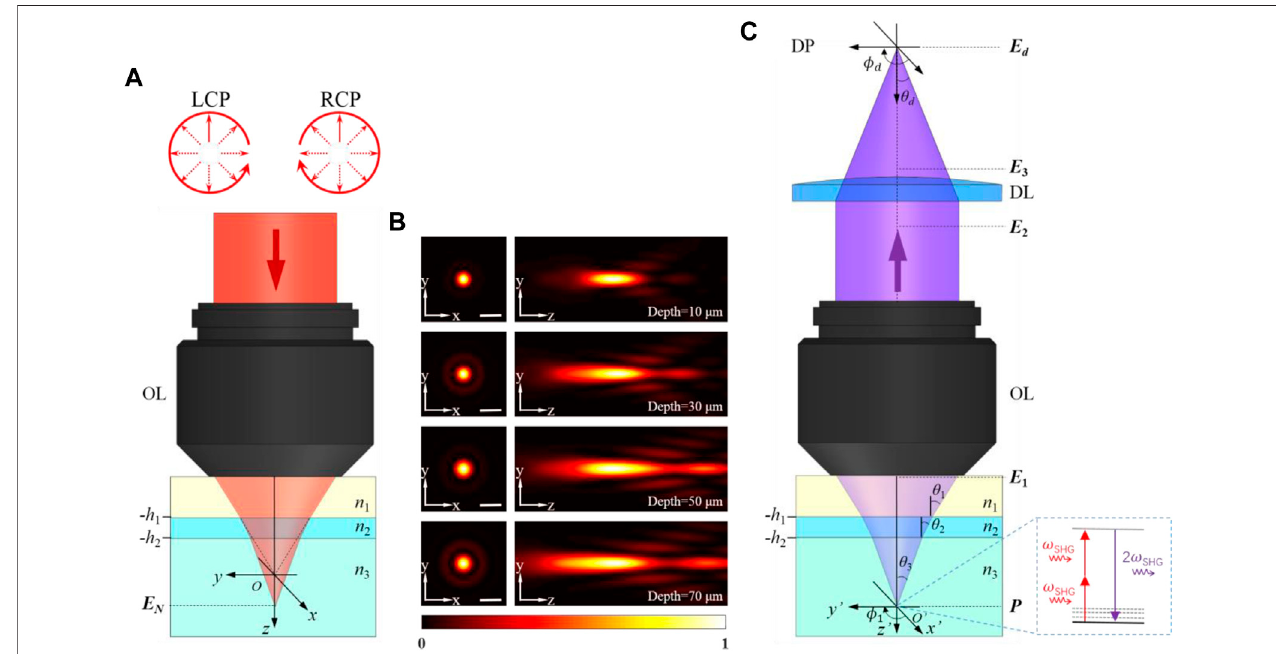
FIGURE1|(A) Schematicoffocusingthroughathree-layerstrati fi edmedium forleft-handedandright-handedcircularpolarizedbeams.Theorigin O ofthe( x , y , z ) reference frame locates at the nominal focal point position. (B) Near-focus excitation intensity distributions at different depths. (C) SHG radiation imaged through the same medium. The specimen is placed at the origin O ’ of the ( x ’ , y ’ , z ’ ) reference frame. LCP: left-handed circular polarization, RCP: right-handed circular polarization, OL: objective lens, DP: detector plane, DL: detector lens. Scale bar, 1 μ m.